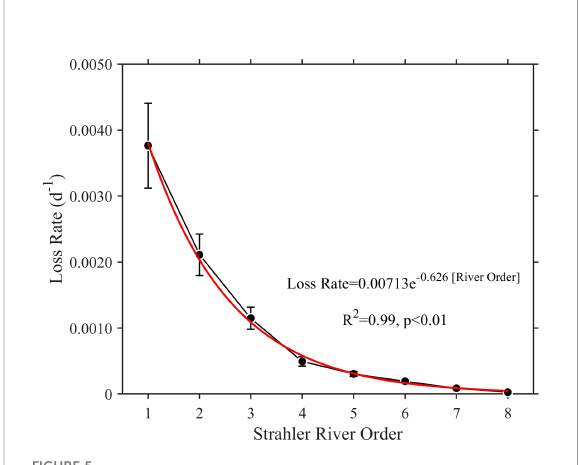
FIGURE 5 Relationships between N 2 O loss rate ( z ) and river